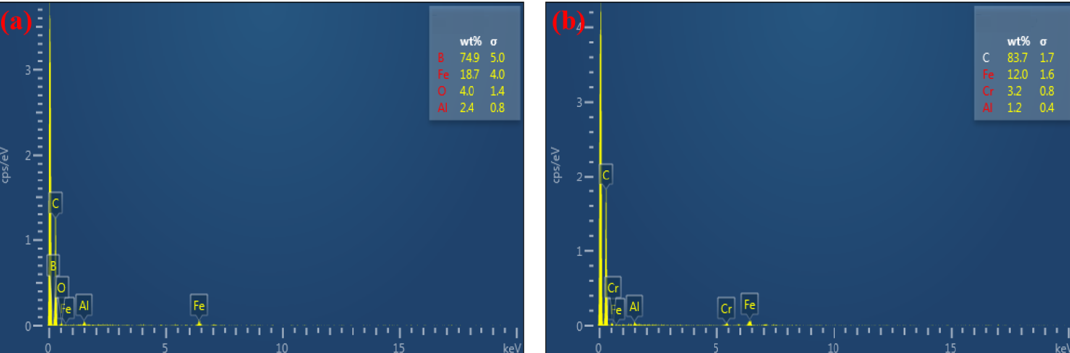
Figure 13. EDS analysis results of the debris in Figure 12. ( a ) corresponds to A area and ( b ) corre- sponds to B area.